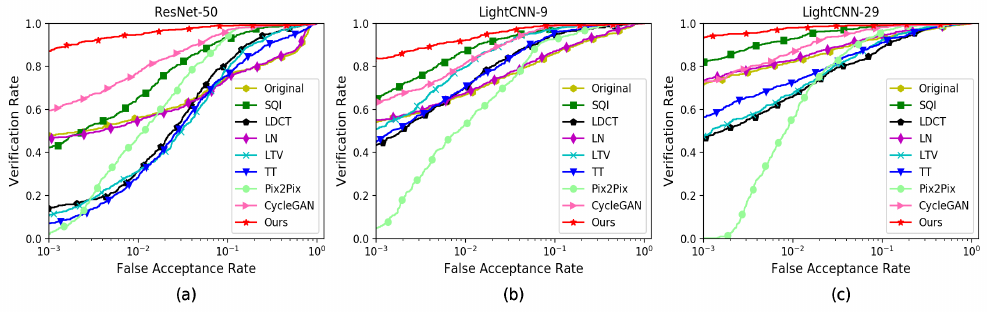
Figure 10. The ROC curves of face verification using ResNet-50, Light-CNN-9 and Light-CNN-29 on the YaleB dataset. ( a ) ROC curves of ResNet-50; ( b ) ROC curves of Light-CNN-9; ( c ) ROC curves of Light-CNN-29.